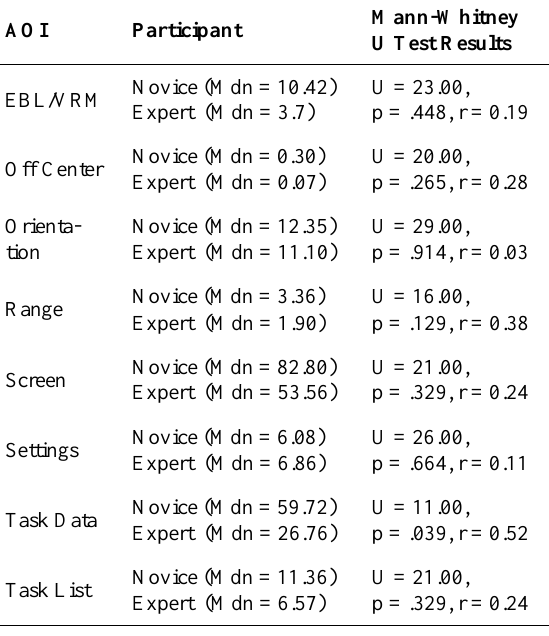
Table 6. Mann-Whitney U Test Results for total fixation dura- tions of novice and expert participants on radar exercise.